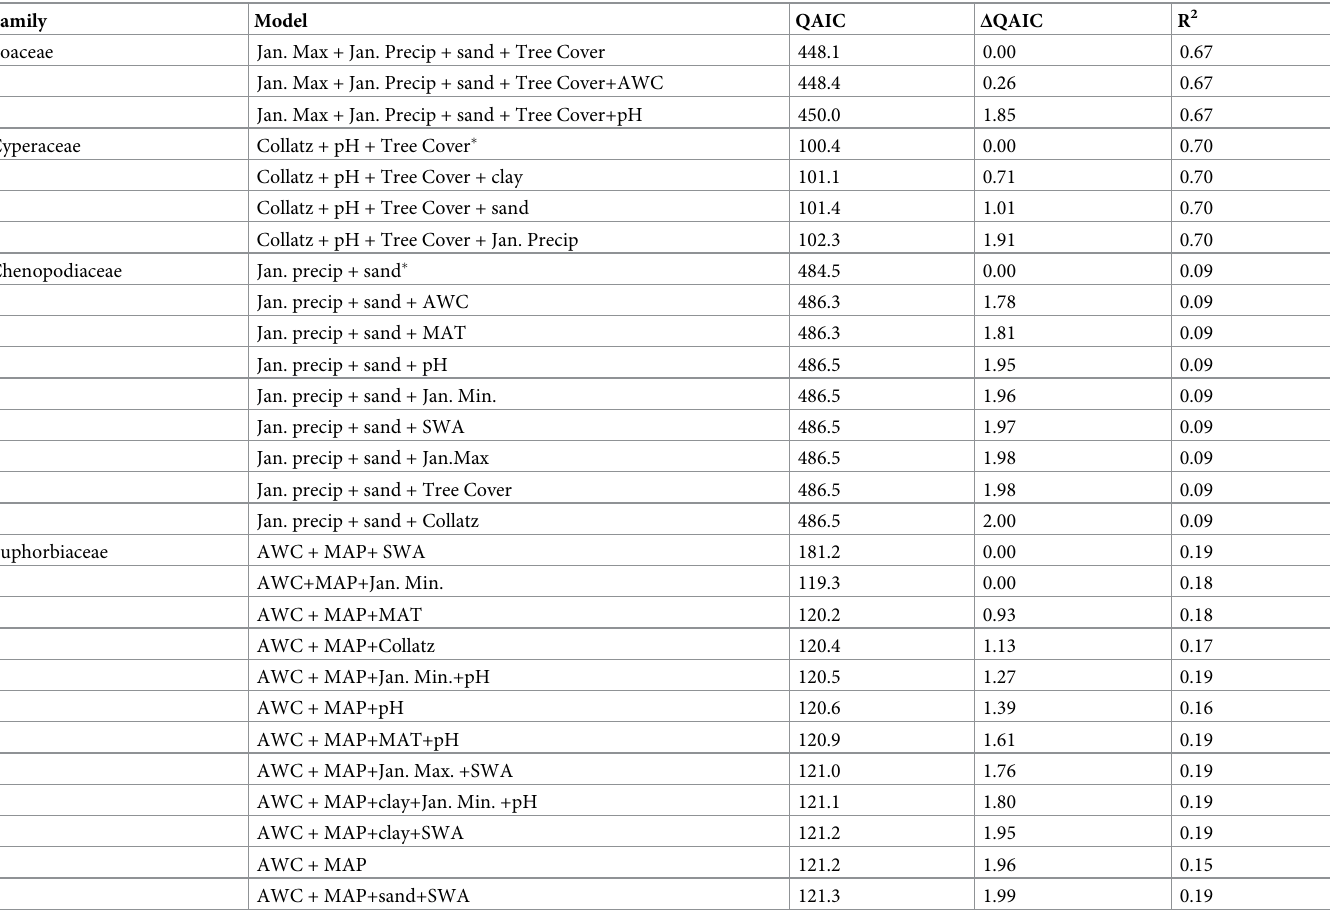
Table 1. Binomial logistic regression model selection results of proportional C 4 richness for Poaceae, Cyperaceae, Chenopodiaceae, and Euphorbiaceae.